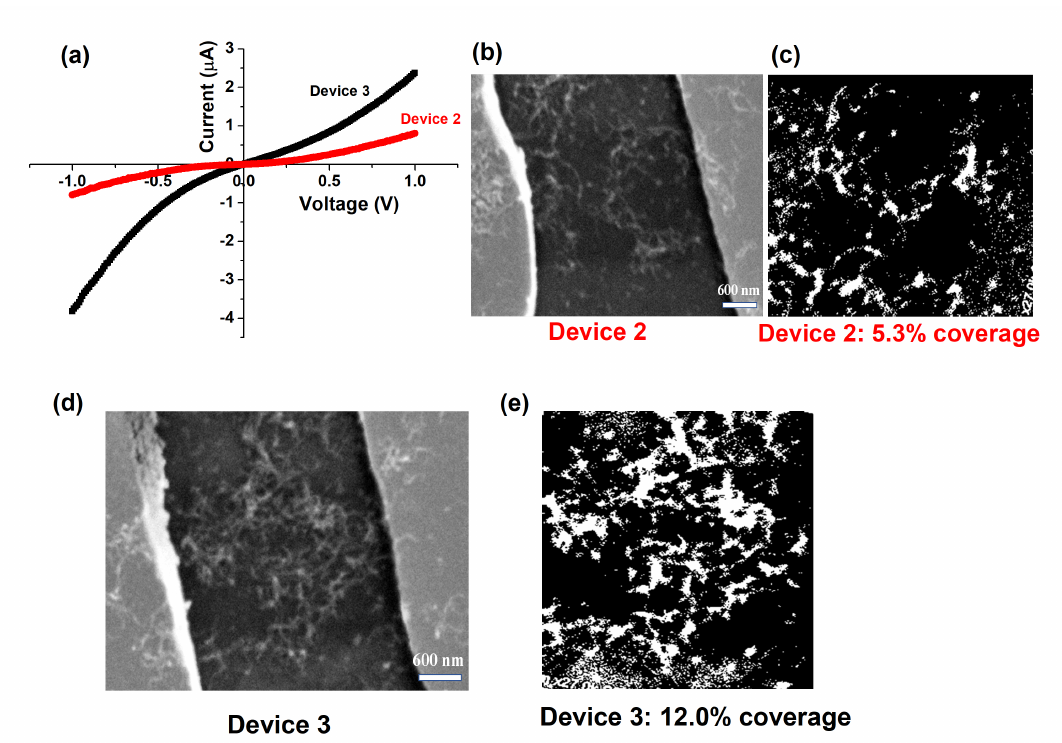
Figure 6. ( a ) Current-voltage characteristics for CNT devices 2 and 3 that have a significant number of interconnected MWCNTs in the network, ( b , c ) SEM image and corresponding binary image of device 2 showing few interconnected CNTs in the channel, corresponding to an areal coverage of 5.3%, ( d , e ) SEM image and corresponding binary image of device 3 showing a higher density of interconnected CNTs in the channel, corresponding to an areal coverage of